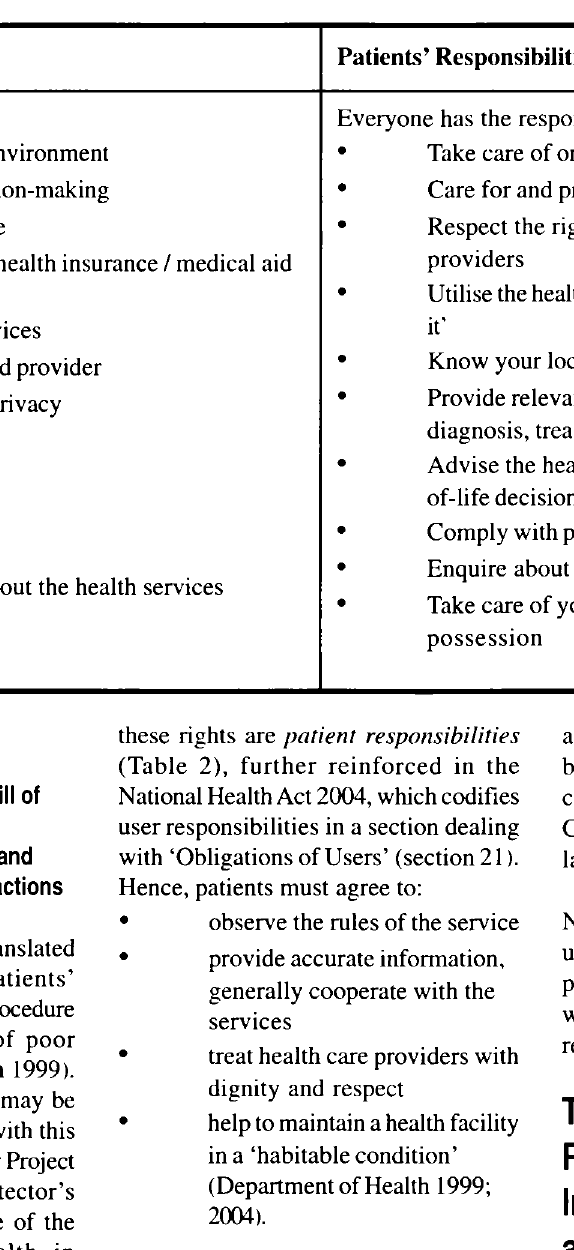
Table 2. The Patients’ Charter: Rights and Responsibilities Patients’